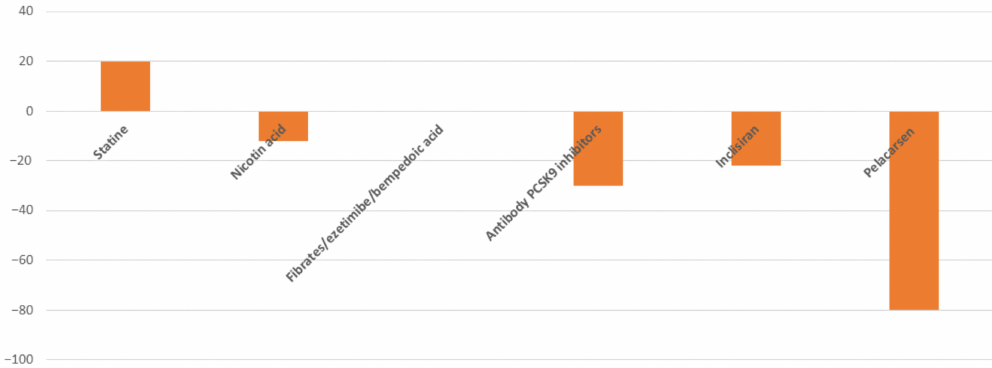
Figure 2. Impact of lipid-lowering treatments on Lp(a) serum